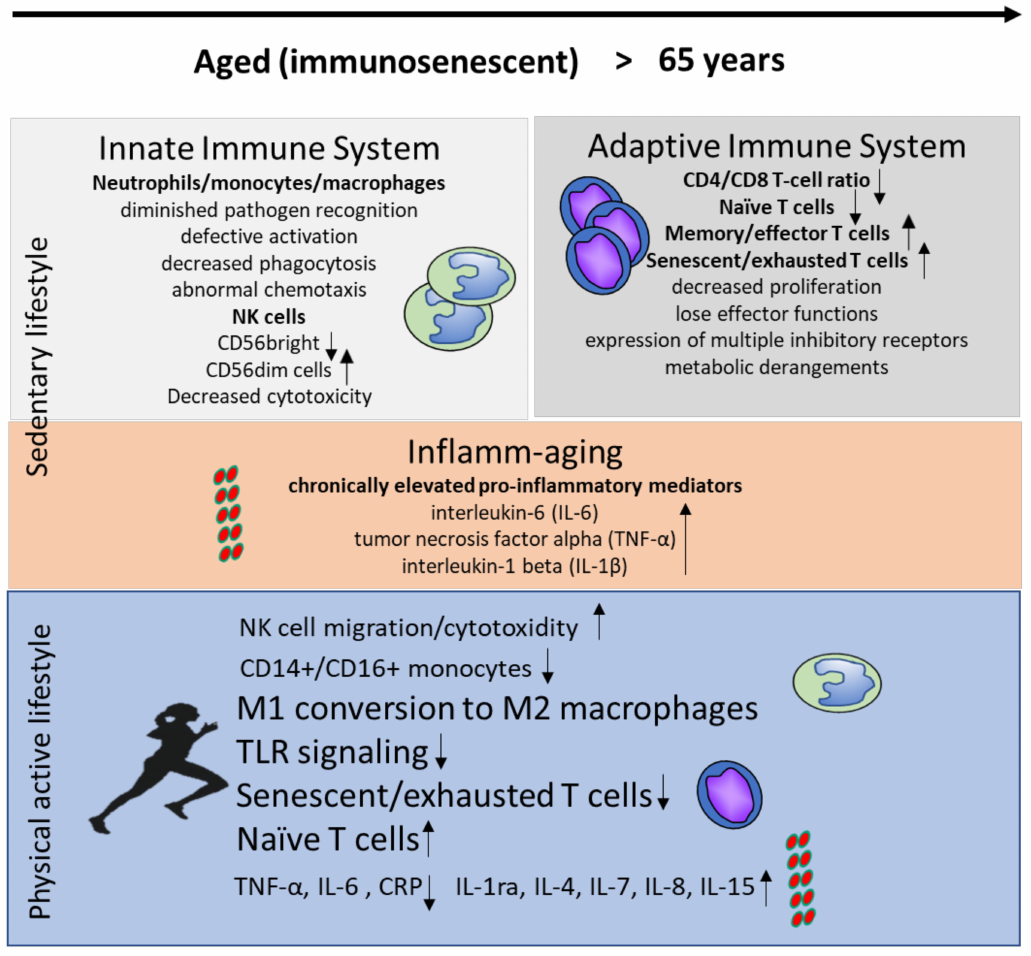
Figure 1. Immune changes in the innate and adaptive immune system during aging in inactive individuals and in response to a physically active